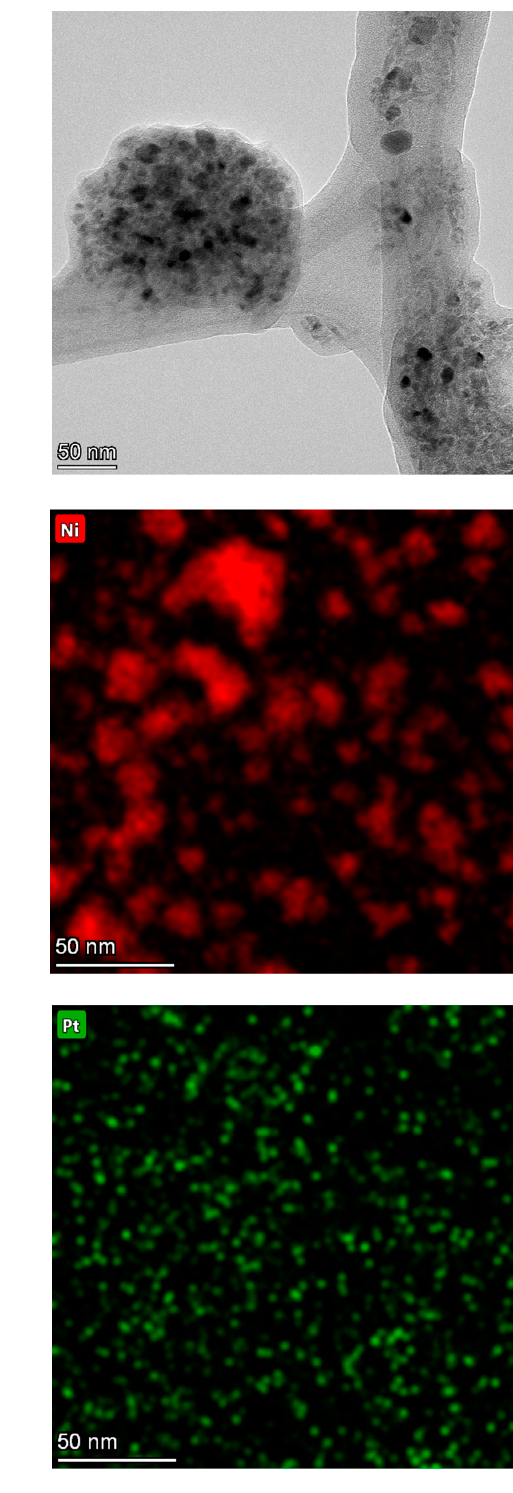
Figure A11. TEM micrographs and elemental maps of the fresh ( left ) and spent ( right ) Pt-promoted catalysts showing both the formation of large Ni particles during catalyst aging and the degree of association between Ni and Pt in the fresh and spent formulations. Note that micrographs and elemental maps correspond to different regions.